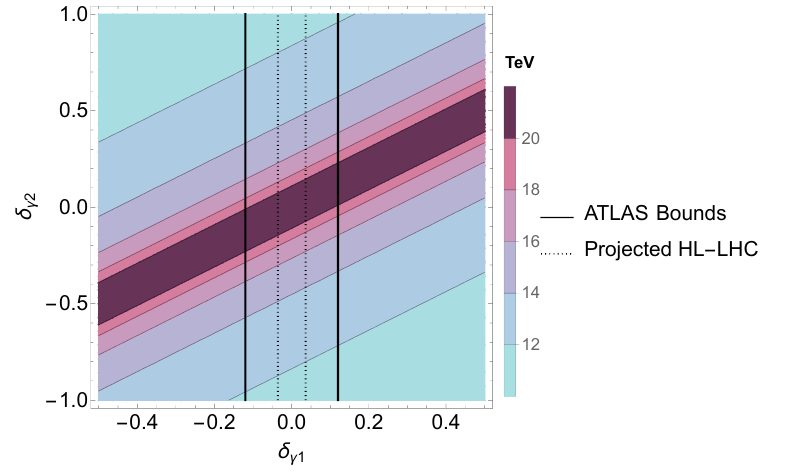
Figure 6 . The unitarity-violating scale that depends on both δ γ 1 and δ γ 2 . The solid black line represents the 95% C.L. limits on δ γ 1 from ATLAS [25], whereas the dotted line represents the 95% HL-LHC projections [20]. Here we set an upper limit on | δ γ 2 | ≤ 1